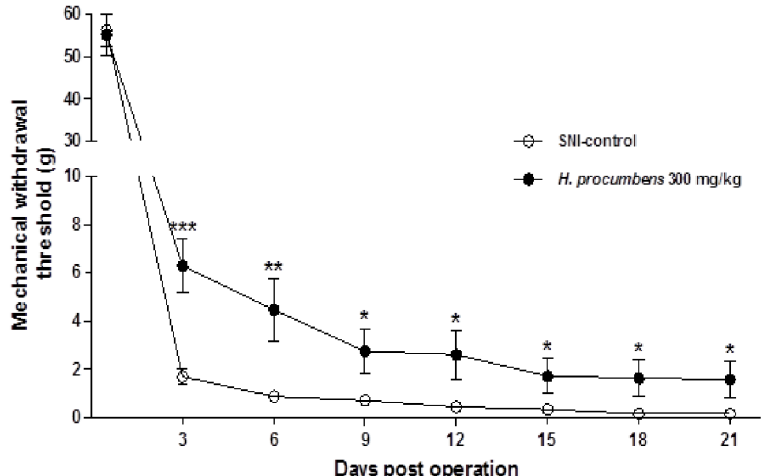
Figure 3. Anti-allodynic effects of H. procumbens extracts treatment in SNI rat model of neuropathic pain. Administration of H. procumbens extracts (300 mg/kg, p.o) significantly attenuated allodynia in response to von Frey stimulation of hind paw from 3 to 21 day after treatment. Data are mean ± SEM (n = 6 per group). *** p < 0.001, ** p < 0.01, and * p < 0.05 significant difference from control